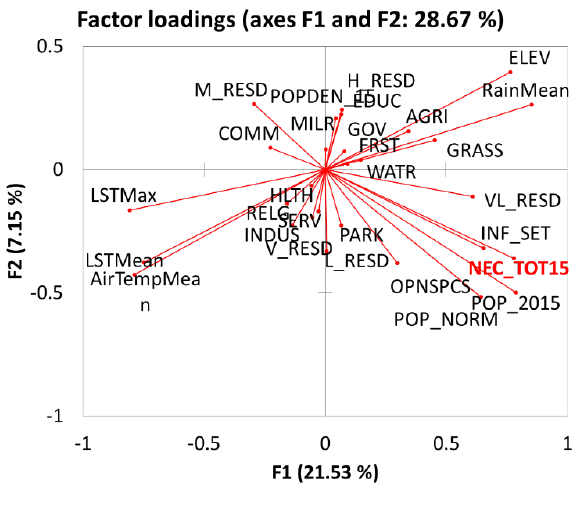
Figure 7. Factor loadings